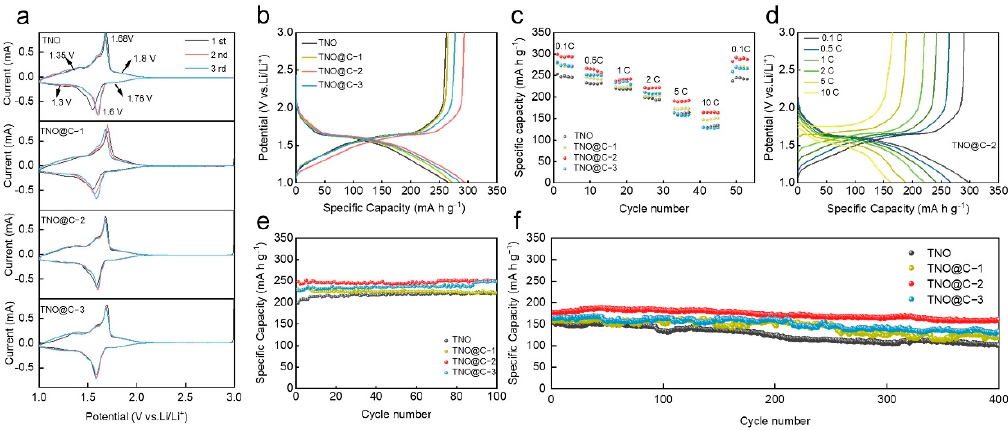
Figure 5 . ( a ) CV profiles of TNO, TNO@C at 0.1 mV s − 1 ; ( b ) Discharge/charge profiles of TNO and TNO@C in the FIRST cycles at 0.1 C; ( c ) rate performance of TNO and TNO@C; ( d ) discharge/charge curve of TNO@C-2 at different C-rates; cycling stability of TNO and TNO@C-2 at ( e ) 1 C and ( f ) 10 C.